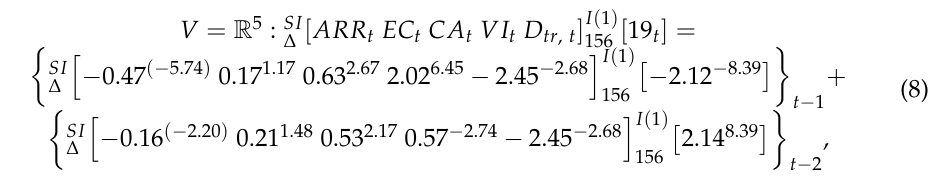
Figure 4. Differenced variables. Sources: authors compilation based on Table 2.